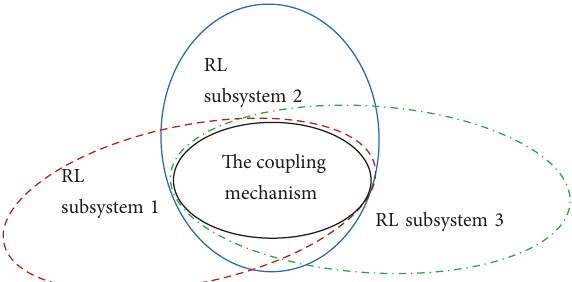
Figure 2: The constitution of the RL architecture.